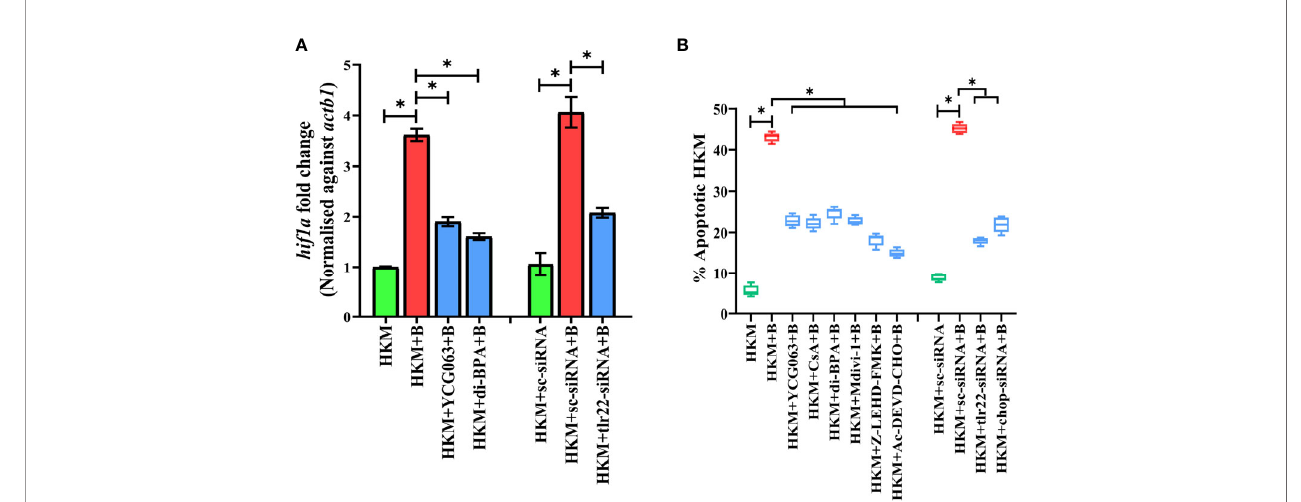
FIGURE 3 | TLR22 induces pro-apoptotic mtROS-dependent HIF-1 a activation in A. hydrophila -infected HKM. (A) HKM pre-incubated with YCG063, di-BPA or transfected with sc-siRNA, tlr22-siRNA were infected with A. hydrophila , and the expression of hif1a mRNA studied at 4 h p.i. Vertical bars denote mean ± SEM (n=3). Asterisk (*) signi fi es signi fi cant difference between the indicated group (* p < 0.05). (B) HKM were pre-incubated with YCG063, CsA, di-BPA, Mdivi-1, Z-LEHD-FMK, Ac-DEVD-CHO or transfected with sc-siRNA, tlr22-siRNA, chop-siRNA were infected with A. hydrophila and at 24 h p.i., Hoechst-positive HKM were enumerated at 24 h p.i. Data are presented as box- and-whisker plots (n=5), shows the medians and 25 th and 75 th percentiles, and the whiskers show 10 th and 90 th percentiles. HKM, uninfected HKM; HKM+B, HKM infected with A. hydrophila ; HKM+YCG063+B, HKM+di-BPA+B; HKM pre-incubated with YCG063 and di-BPA respectively were infected with A. hydrophila ; HKM+sc-siRNA,